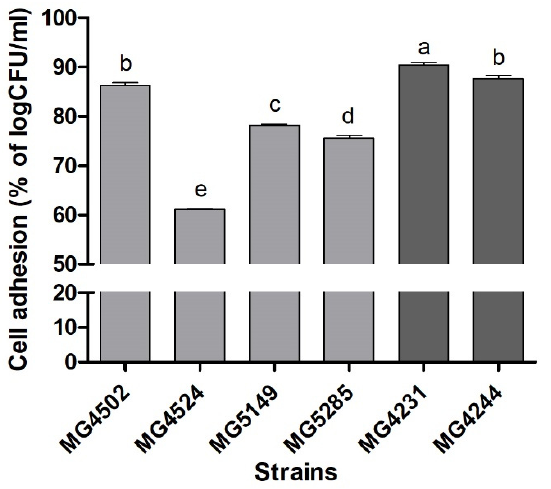
Figure 4. Adhesion ability of the selected strains. Adhesion ability to HT-29 cell was measured. All values are presented as the mean ± SD from three independent experiments. Different letters indicate significant differences between means at p < 0.05 by Tukey’s multiple comparison tests.